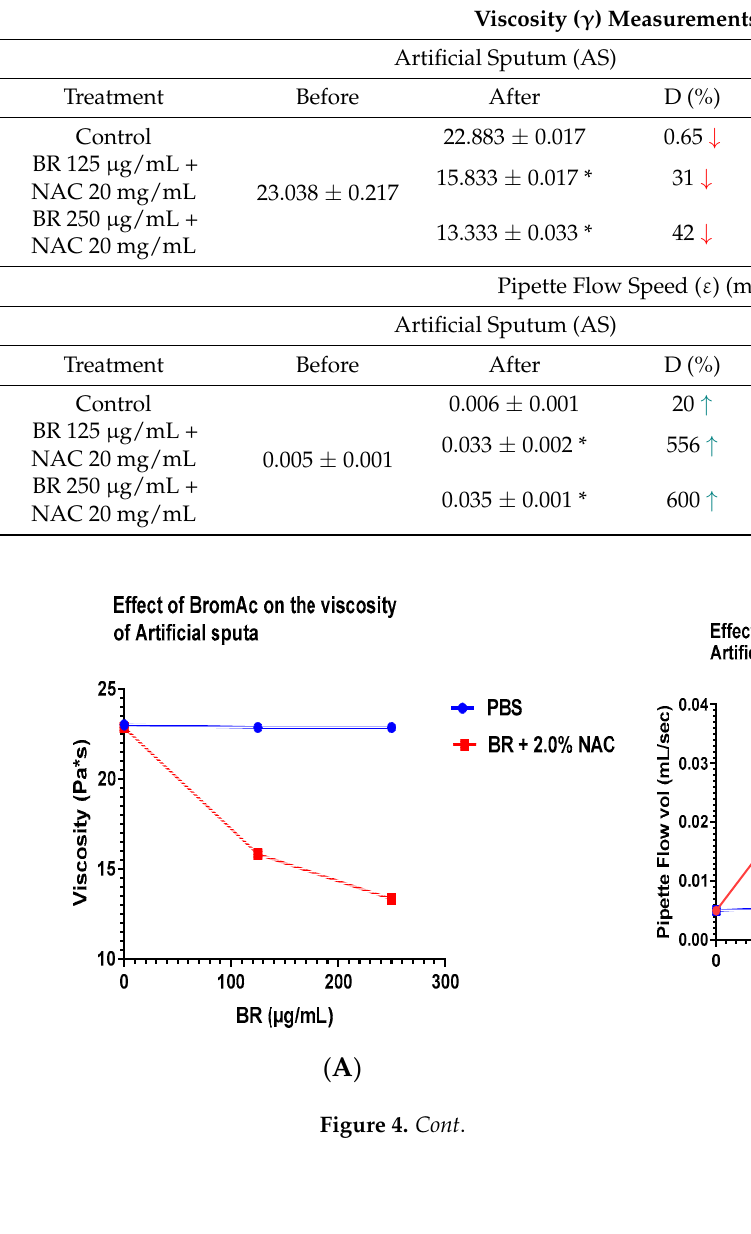
Table 4. The effect of aerosolized BromAc (bromelain (BR) 125 or 250 µ g/mL + NAC 20 mg/mL) on both artificial (AS) and simulated sputa (SS) using two parametric measurements such as viscosity ( γ ) and pipette flow time ( ε ). Data presented as mean ± SD. Test samples were compared with control after treatment for significance testing; * = p < 0.05; ↓ = decrease; ↑ = increase.